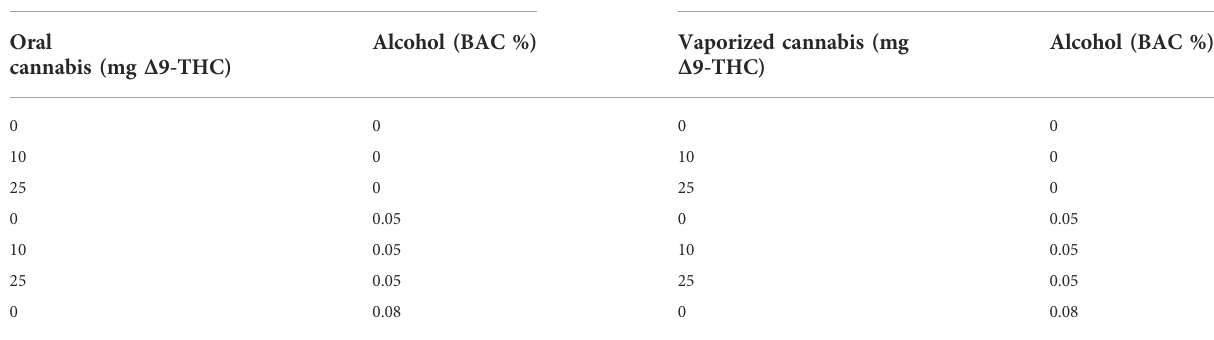
TABLE 1 Study drug and dose